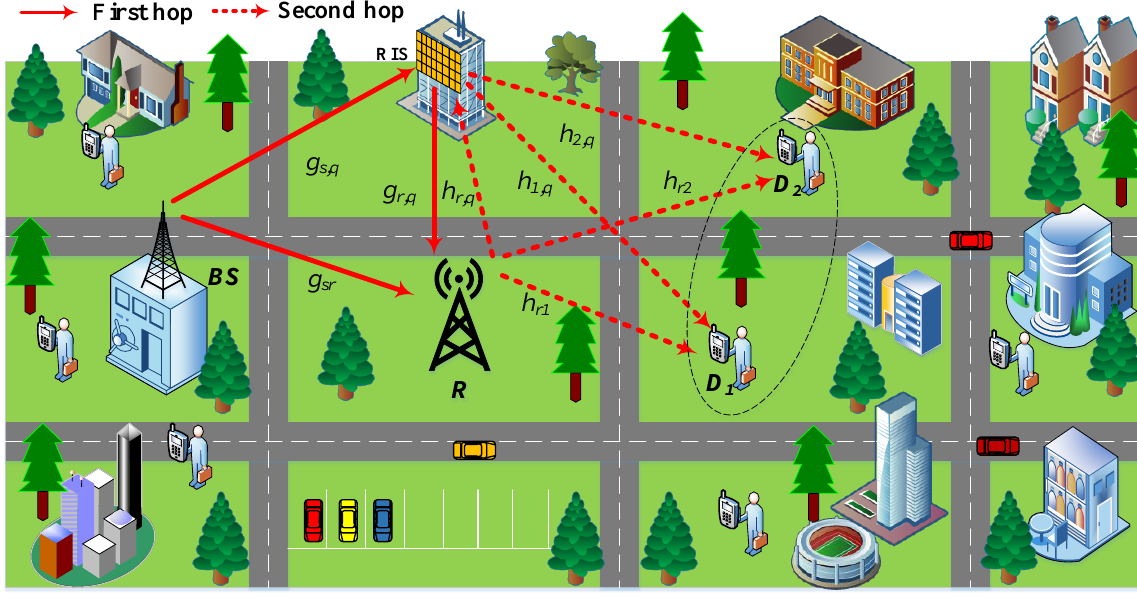
Figure 1. Hybrid relay RIS-aided IoT for downlink NOMA